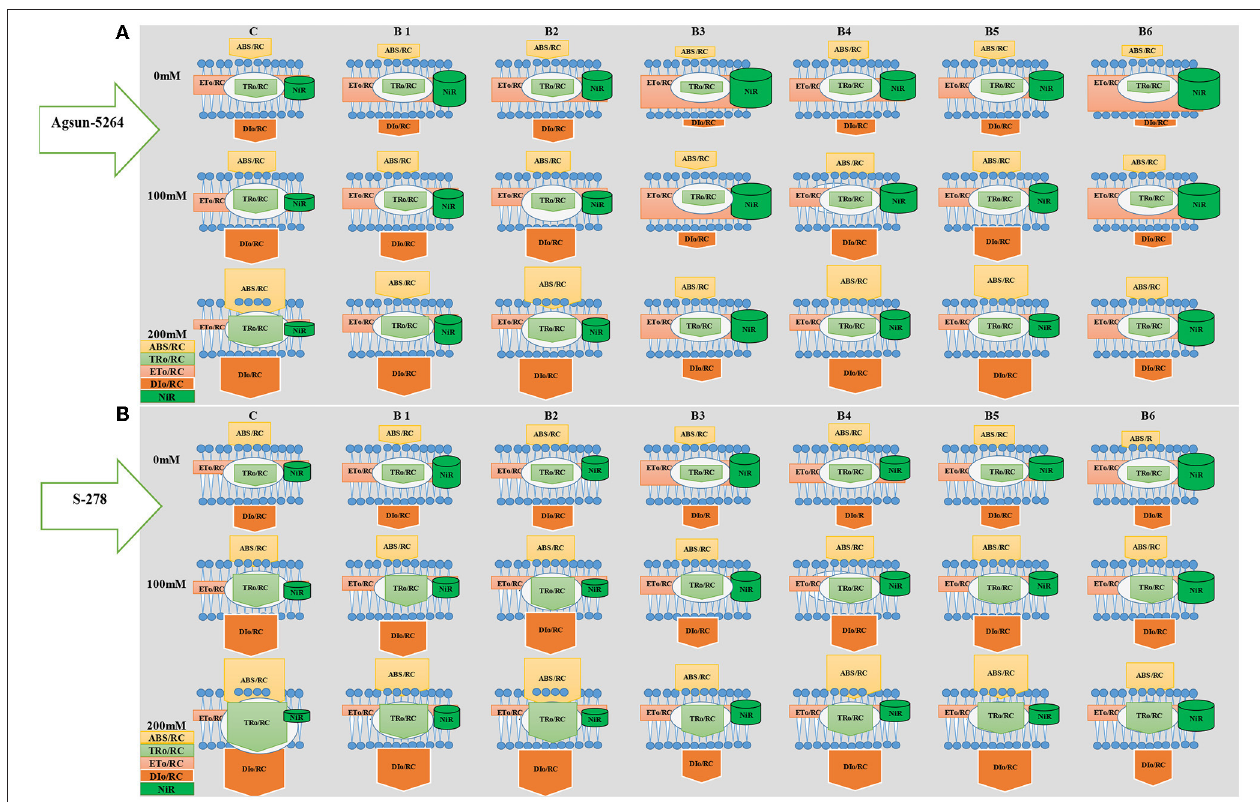
FIGURE 8 | Energy pipeline model showing the proportion of specific energy fluxes per active PSII and NiR activity in the membrane of salt-stressed sunflower cultivars Agsun-5264 with or without microbial strains. In the membrane, ABS/RC, TR O /RC, ET O /RC, and DI O /RC indicate absorption, maximum trapped exciton flux per active PSII, electron transport, and dissipation flux, respectively. The value of each parameter can be seen in relative changes in the width of each arrow ( see the color legend). The diagram exhibits the variation of ABS/RC, TR O /RC, ET O /RC, and DI O /RC, for seven treatments, namely, C = Without Bacillus species, B1 = Bacillus cereus strain KUB-15 , B2 = Bacillus cereus strain KUB-27 , B3 = Bacillus licheniformis strain AAB9 , B4 = KUB-15 + KUB-27 , B5 = KUB-27 + AAB9 , and B6 = KUB-15 + AAB9. The model was developed by the values of four fluxes and NIR activity. The values of each of the four fluxes and NIR activity can be compared between cultivars and among treatments. The model displays fluxes and NIR activity in different shapes; the size of each shape is proportional to the corresponding normalized value. (A) Agsun-5264 and (B)